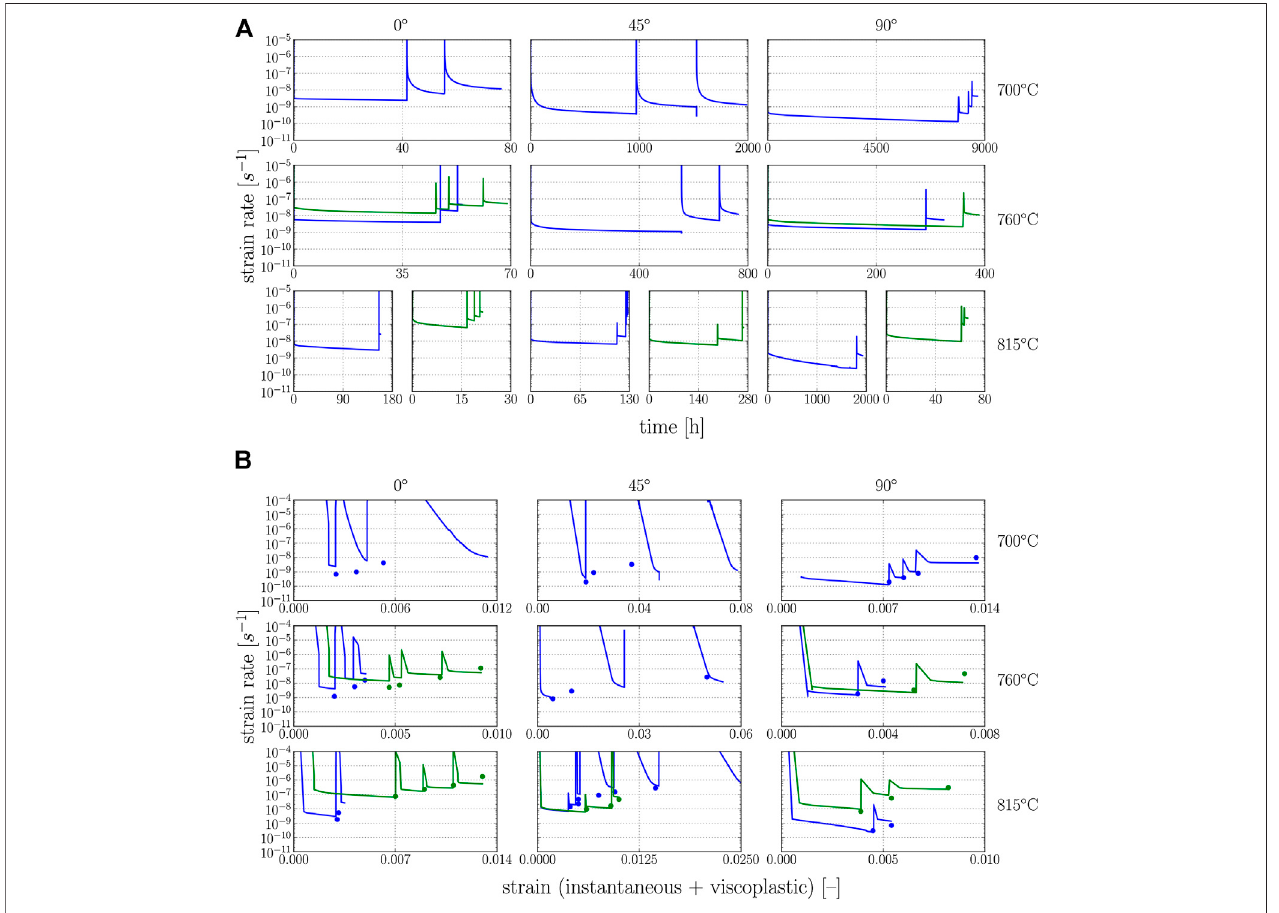
FIGURE8| Simulation results fordifferently oriented PSTcrystalsat thetemperaturesandstresslevels fromtheexperimentalresults inParthasarathyet al.(2000). Symbols: experimentally determined steady-state strain rates at the corresponding strain, that is, at the end of primary creep stage. Solid lines: simulations.